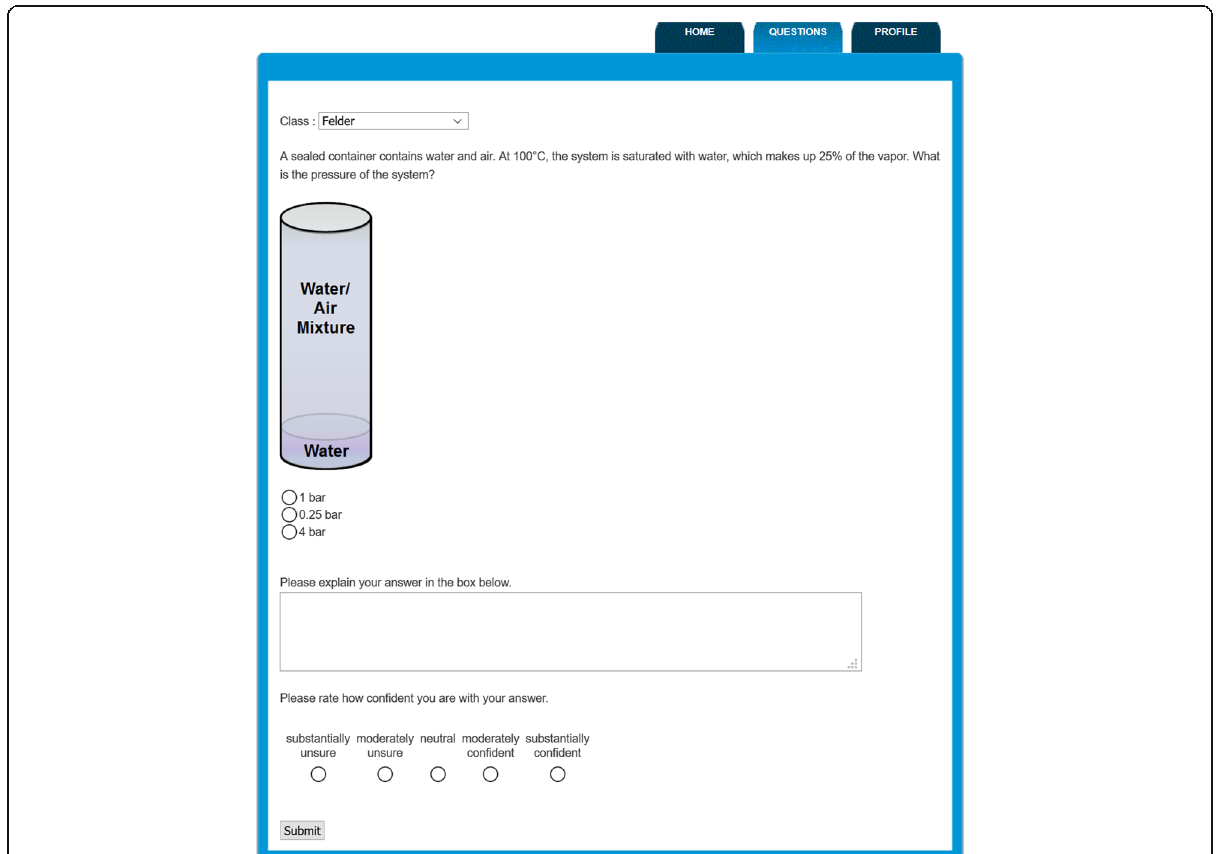
Fig. 3 Example of an engineering ARS question as it was delivered in